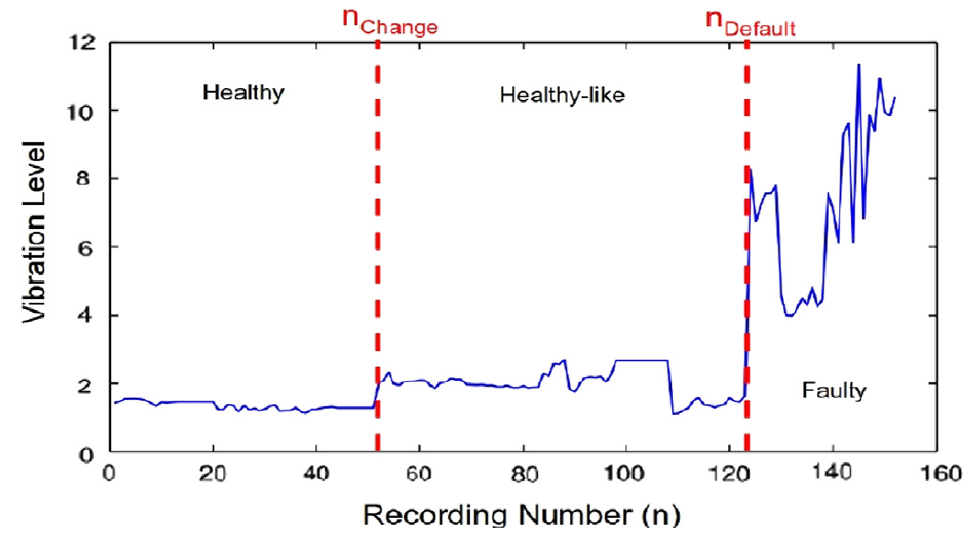
Figure 32. Replacement of healthy bearings with faulty ones by using statistical indicators [80].